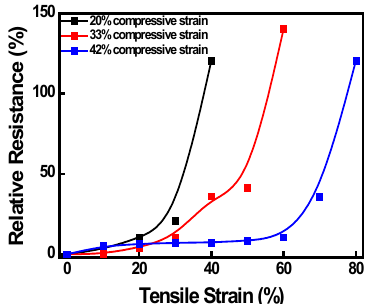
Figure 4. Resistance changes of wrinkled hybrid electrodes according to mechanical tensile strains.